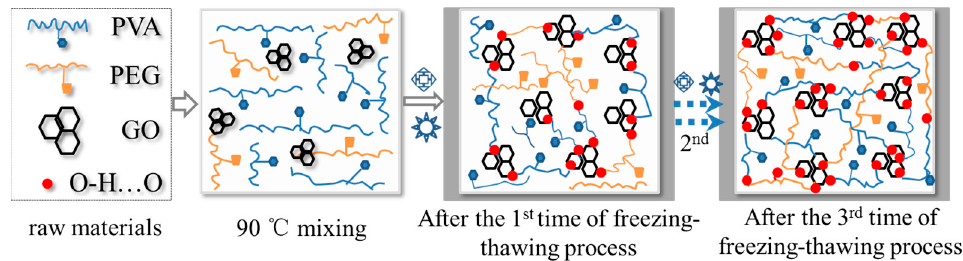
Figure 1. Schematic illustration of the formation mechanism of PVA/PEG/GO hydrogels using the freezing–thawing method (the mark means freezing process, and means thawing process).